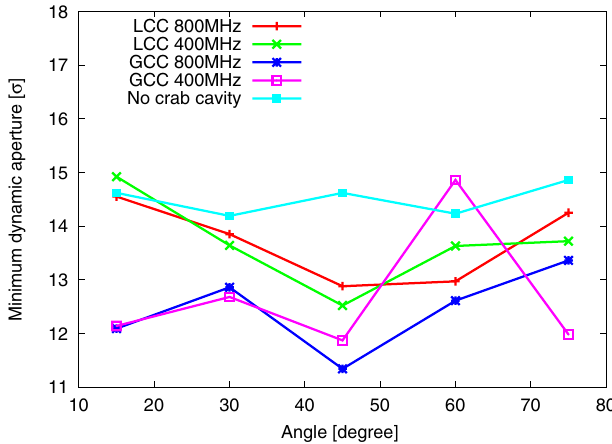
FIG. 7. (Color) Minimum dynamic aperture over 60 error seeds for lowbetamax collision optics with or without crab cavity; the maximum decrease of 1 or 2 (cid:3) due to crab cavity is acceptable. The dynamic-aperture tracking is performed for 100 000 turns.